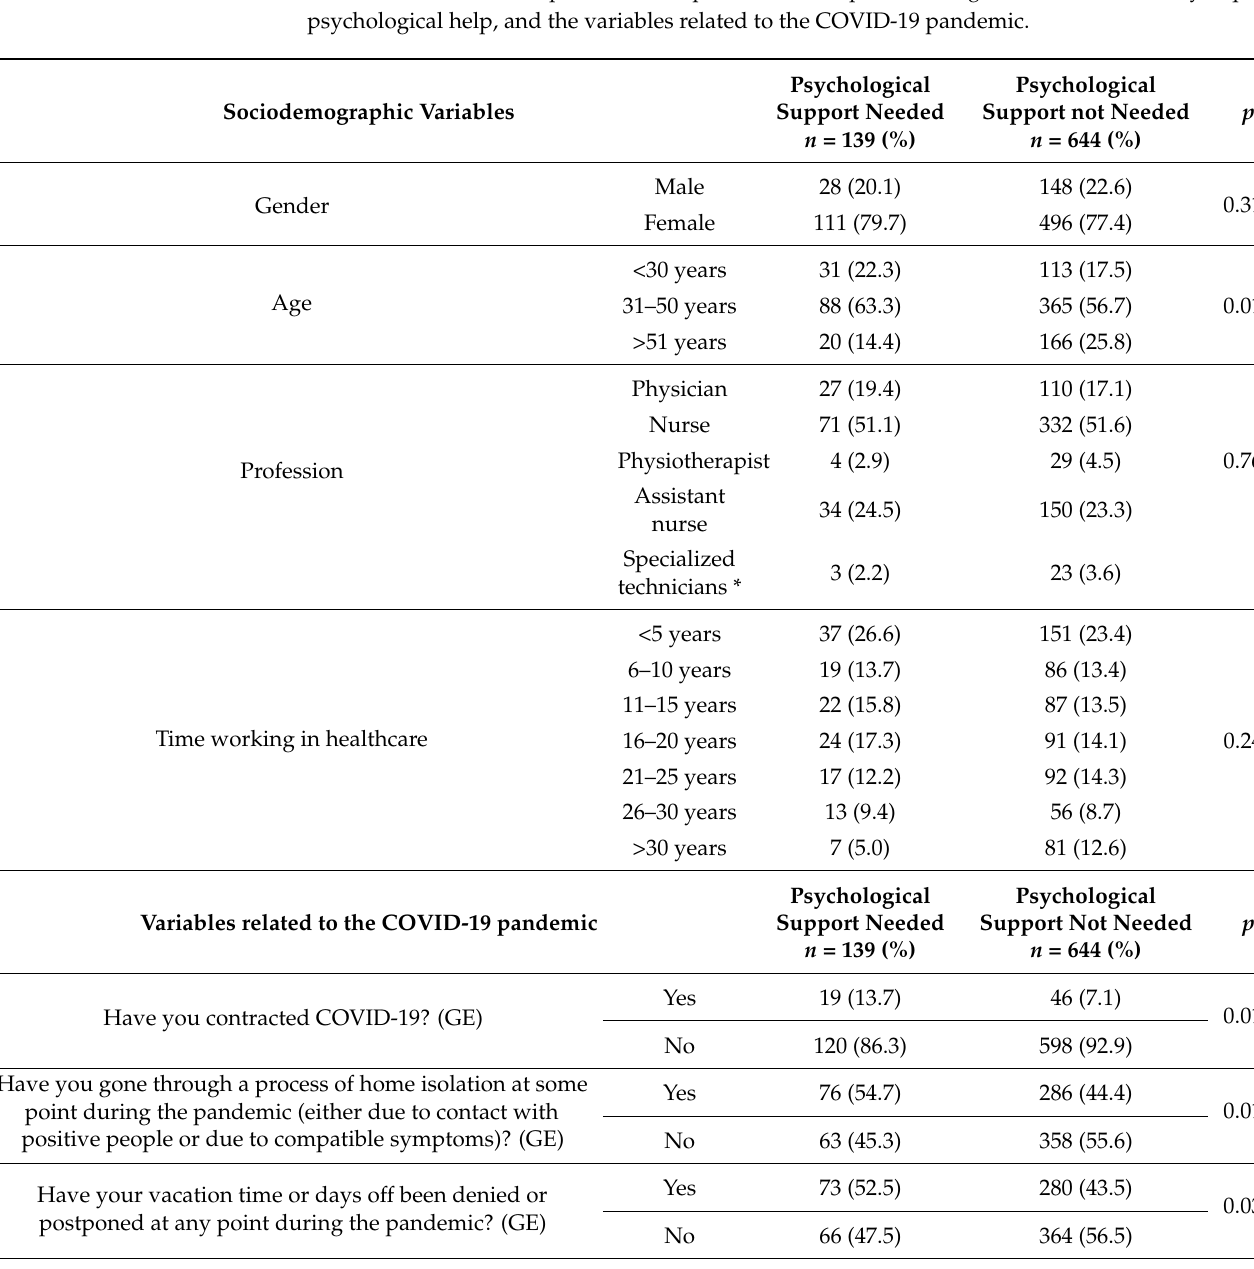
Table A1. Personal–occupational description of the sample according to whether or not they required psychological help, and the variables related to the COVID-19